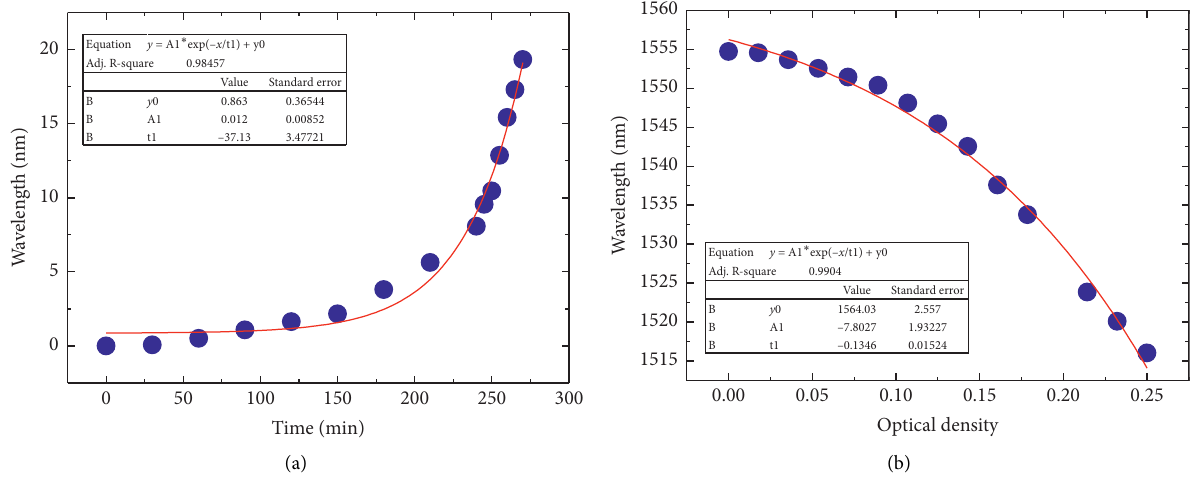
Figure 5: (a) Time-dependent wavelength shift and resonance wavelength was recorded every 30min. (b) The relationship between dip wavelength and optical density.